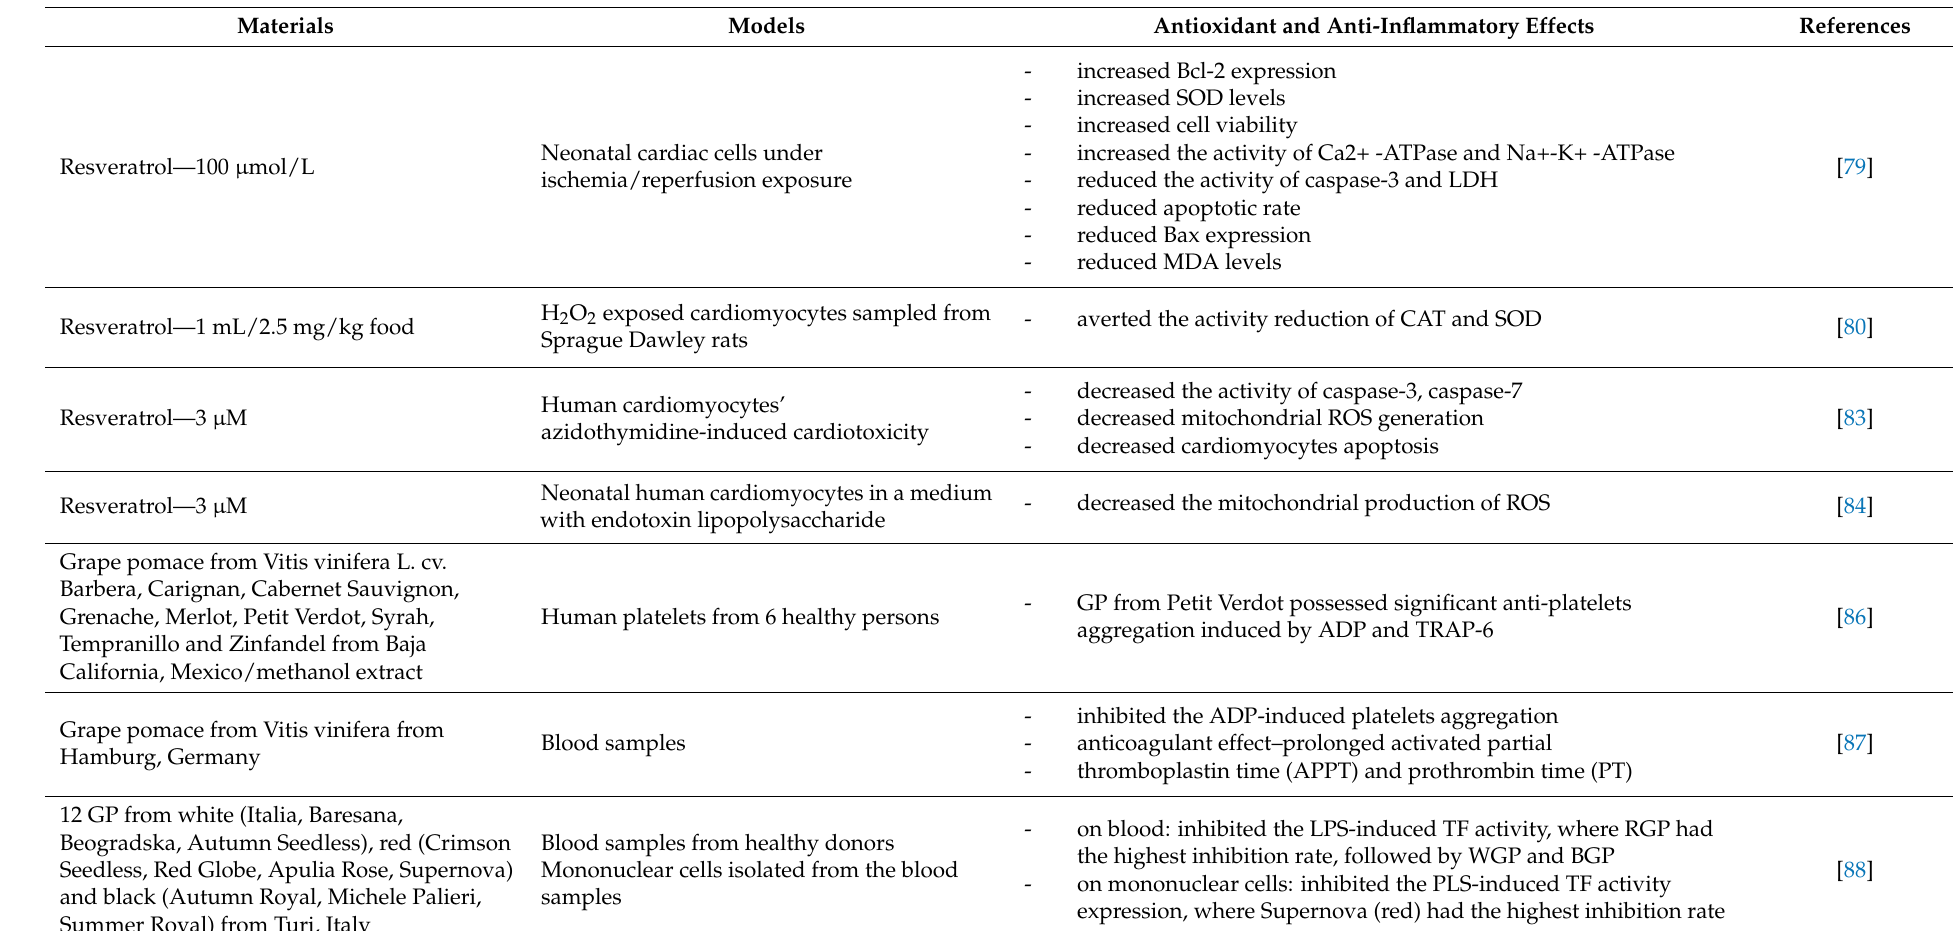
Table 4. The cardioprotective effects, antioxidant, and anti-inflammatory actions of polyphenols and grape pomace on different cardiac experimental